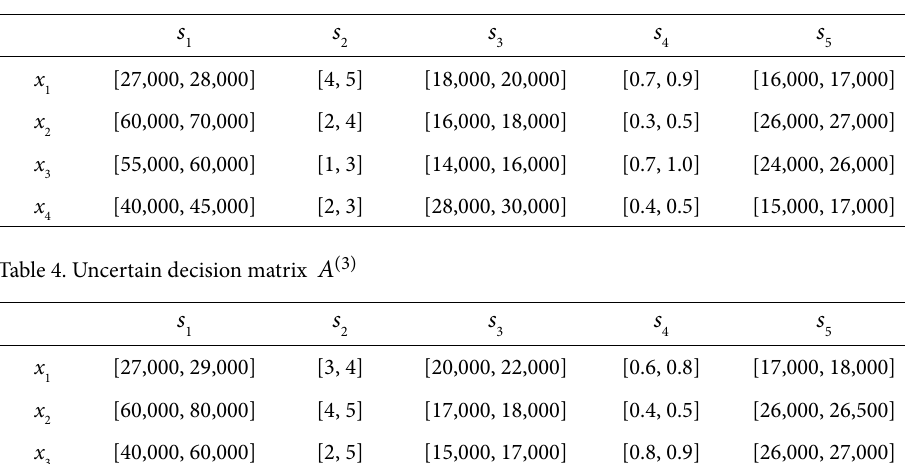
Table 3. Uncertain decision matrix